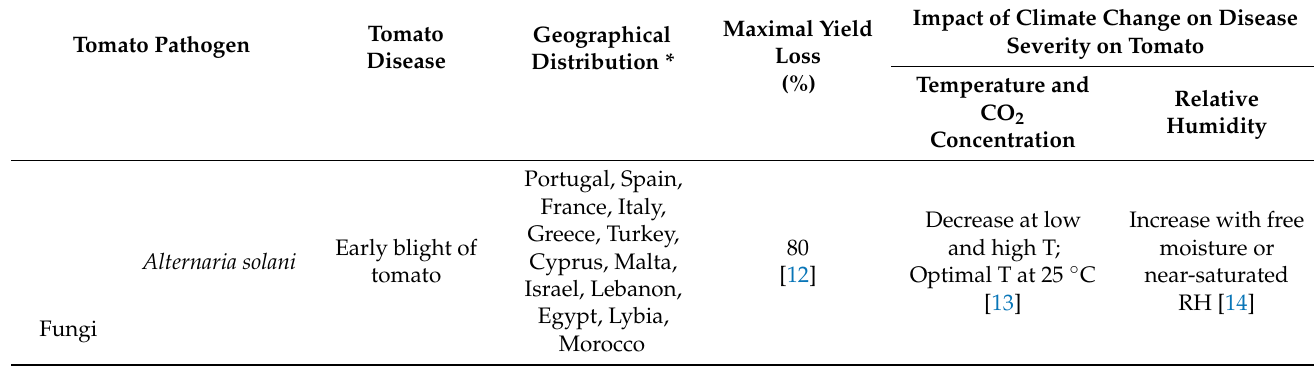
Table 2. List of the tomato pathogens described in this review, their geographical distribution and impact of climate change on the disease